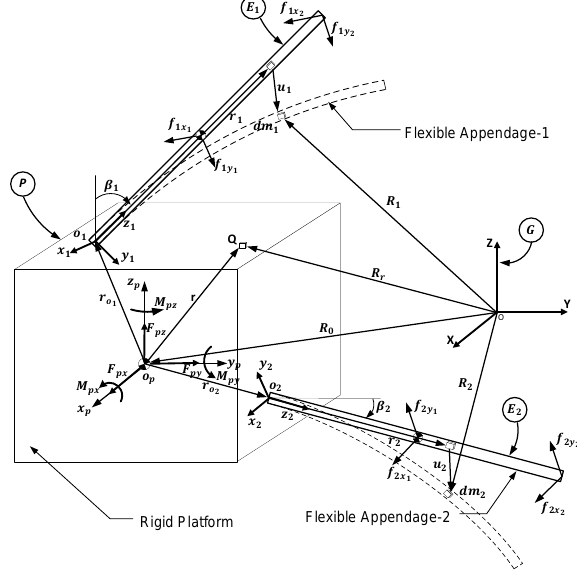
Figure 1. Model of the flexible